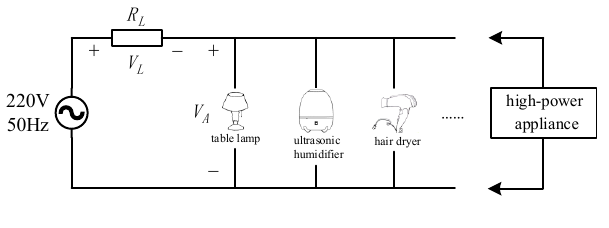
Figure 6. Schematic diagram of the power grid.